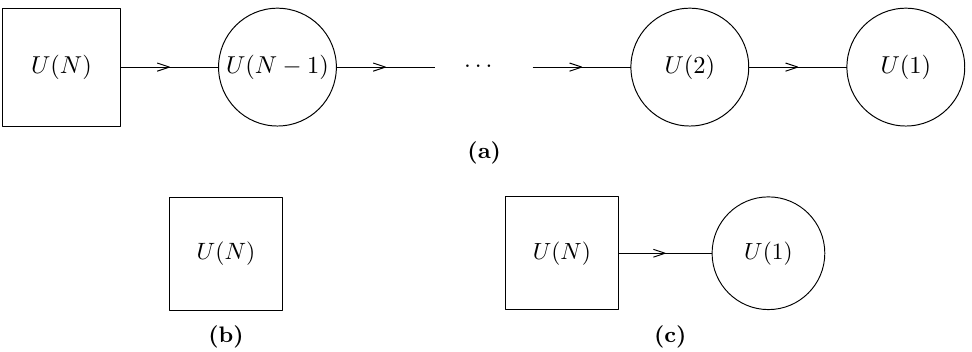
Figure 2. Two-dimensional N = (2 ; 2) defects of type I (a), II (b) and III